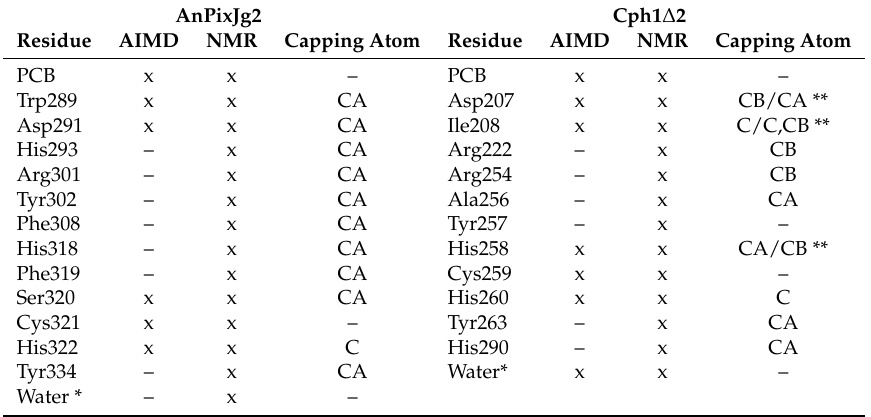
Table 4. Information on protein residues included into the QM part, and corresponding capping atoms for response